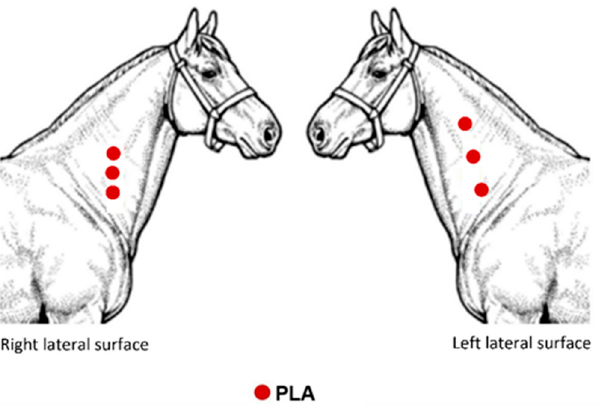
Figure 9. Schematic illustration showing the evaluation sites of a horse implanted with PLA.